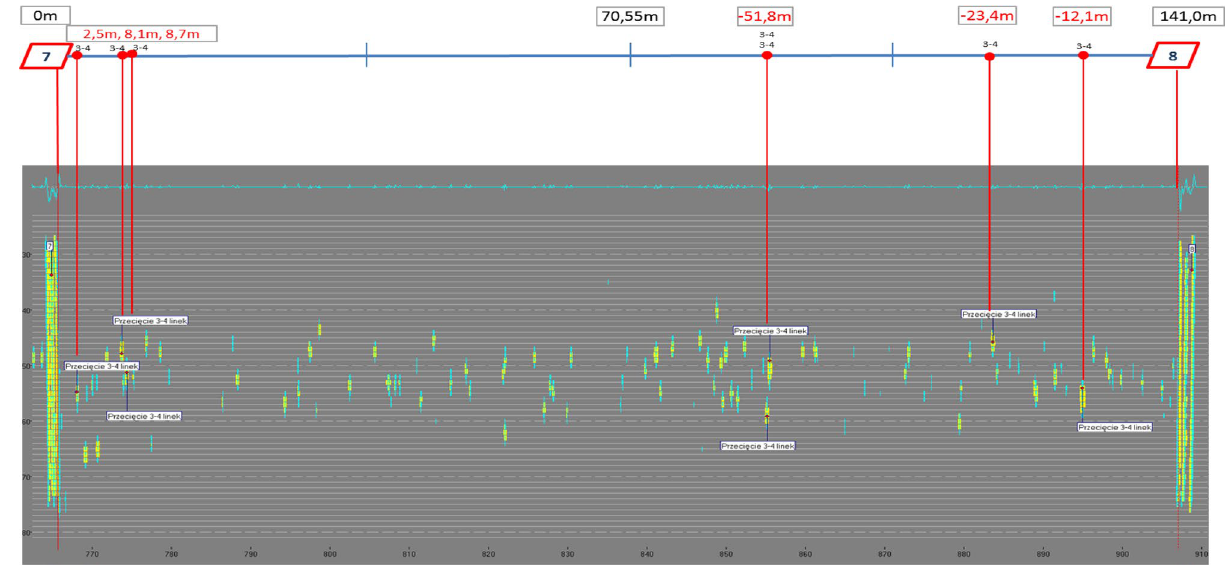
Figure 5. 2D representation of a belt section after 86 months in operation 5,42 (screenshot of DiagBelt proprietary software) (screenshot of Belt Analysis software version 0.6, http:// www. belts can.